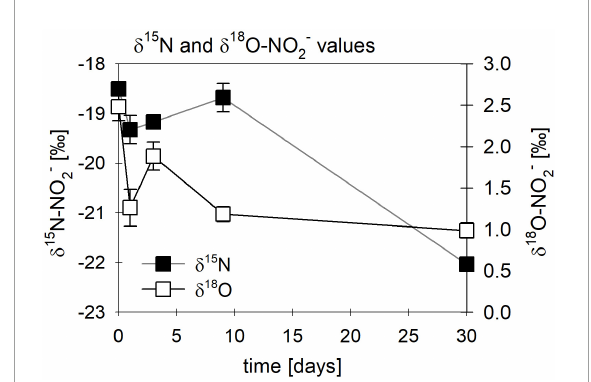
FIGURE11 Changes in δ 15 N ( (cid:4) )/ δ 18 O-NO 2 − ( (cid:3) ) values observed in abiotic nitrite reduction coupled to Fe(II) oxidation over time. Error bars represent standard deviation ( n =